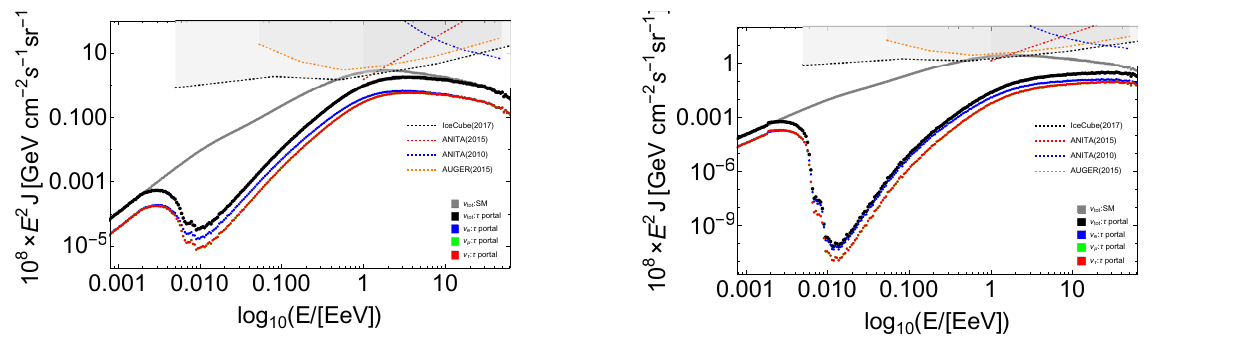
Figure 1. The mean free path for the neutrino in mass eigenstate α as a function of energy. We take M ψ = m φ = 15 MeV and τ = 0 . 4. U τ ˜ y τ | |